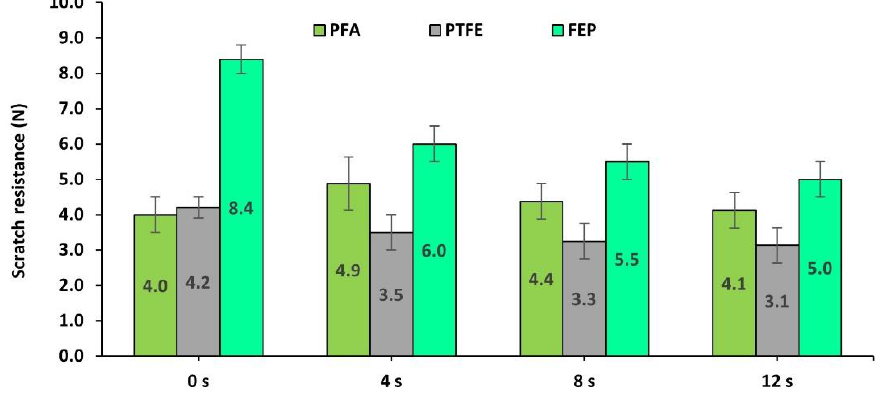
Figure 6. Scratch resistance (N) of the coatings based on PFA, PTFE, and FEP, after 0, 4, 8, and 12 s subjected to the projection of brown corundum particles at 0.4 MPa.